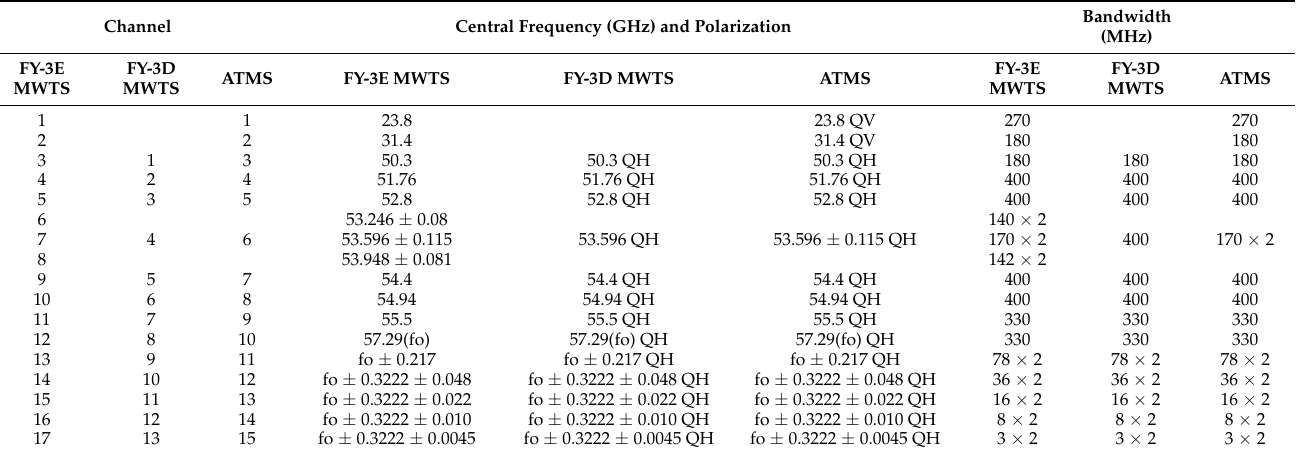
Table 2. Comparison of basic characteristics between FY-3E MWTS-III, FY-3D MWTS-II and ATMS. Channel Central Frequency (GHz) and Polarization Bandwidth